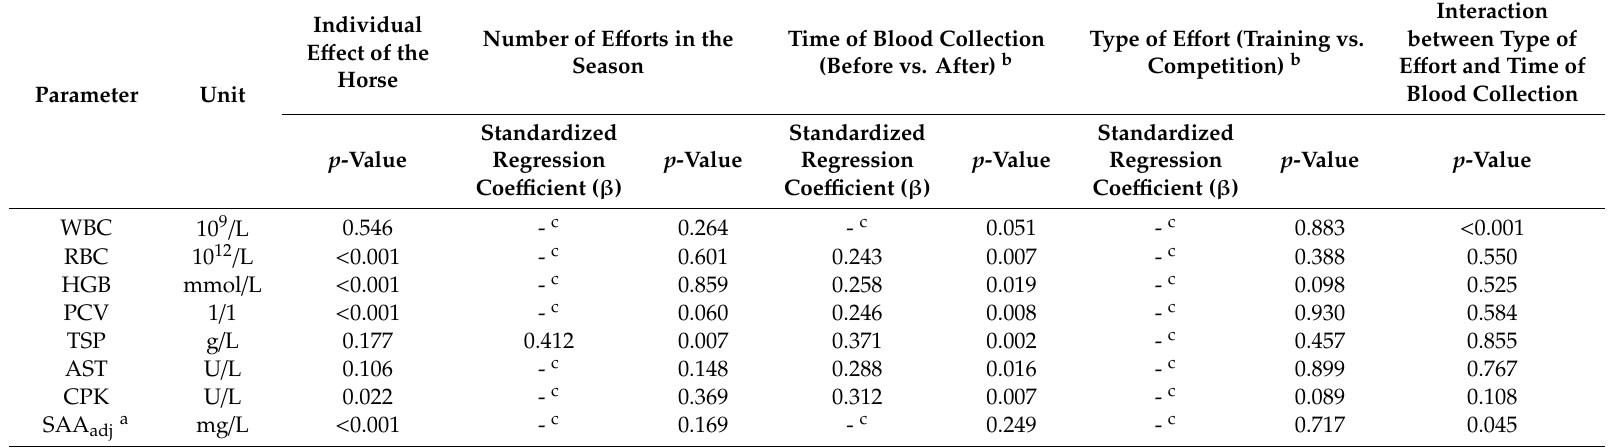
Table 1. Results of the univariate hierarchical linear model investigating the link between four independent variables (number of e ff orts in the season, type of e ff ort, time of blood collection, and the interaction between type of e ff ort and time of blood collection) and the level of hematological and serum biochemical parameters, adjusted by the individual e ff ect of the